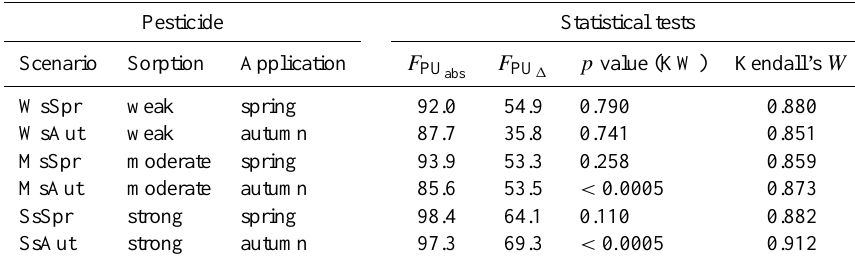
Table 3. Results from the statistical analysis performed for the pesticide application scenarios of the different hypothetical compounds. F PU denotes the ratio of variance within the climate input to the total variance in % for the absolute losses (abs) and for the predicted change ( 1 ). The given p values are the results from the Kruskal–Wallis (KW) test, a non-parametric analysis of variance. Kendall’s W test renders values between 0 and 1 for no agreement and full agreement, respectively, between the ranks for pesticide losses as simulated with the different climate scenarios over the range of acceptable parameterizations of the pesticide fate